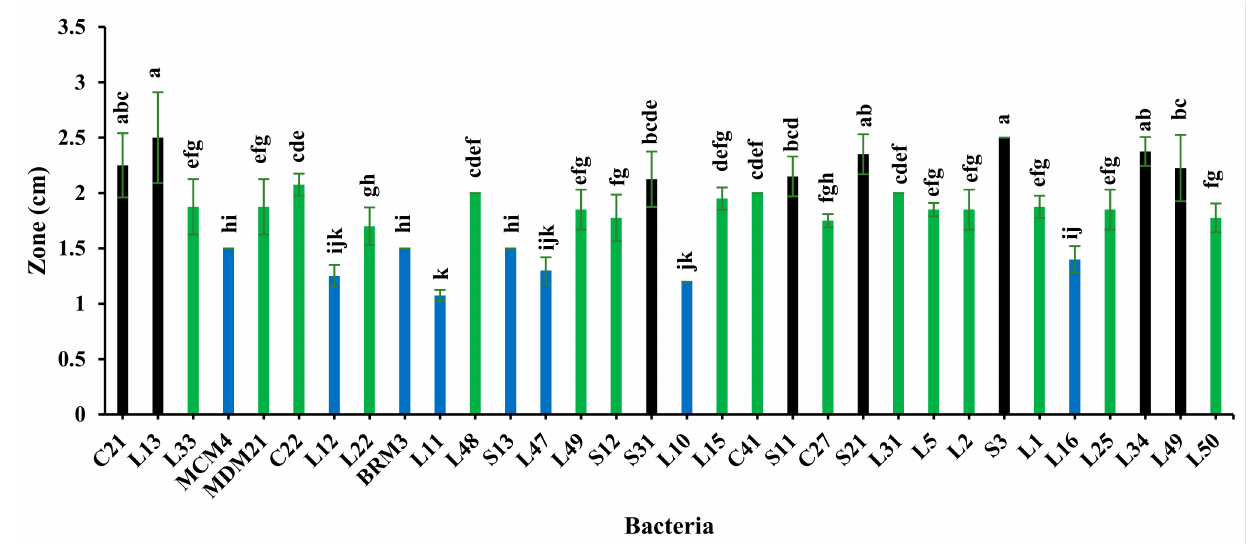
Figure 1. Proteolytic activity of the lactic acid bacteria (LAB) strains isolated from Iranian traditional cheese. Black-colored columns: high proteolytic activity; green-colored columns: medium prote- olytic activity; blue-colored columns: low proteolytic activity. Different letters indicate significant differences between samples at p ≤